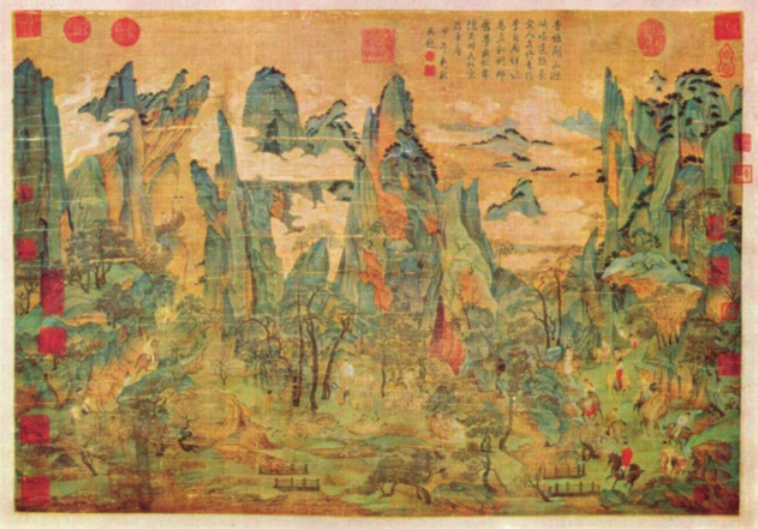
Fig. 1. Li Zhaodao. Emperor Ming Huang’s Journey to